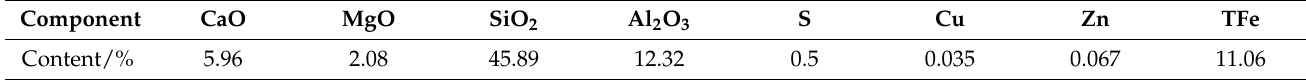
Figure 1. Composition curve of total tailings. Table 1. Chemical constituents of tailings.